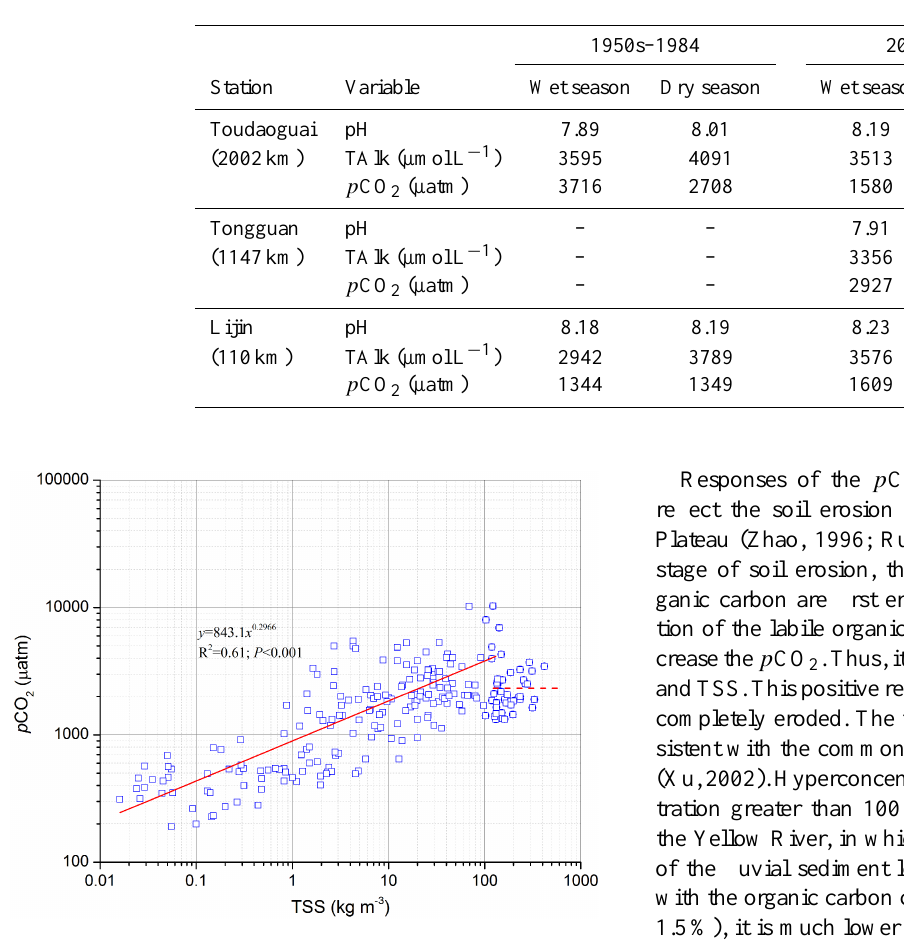
Table 2. Inter-annual and seasonal differences of pH, TAlk, and p CO 2 at the three stations. The number below the station name denotes the channel length to the river mouth.